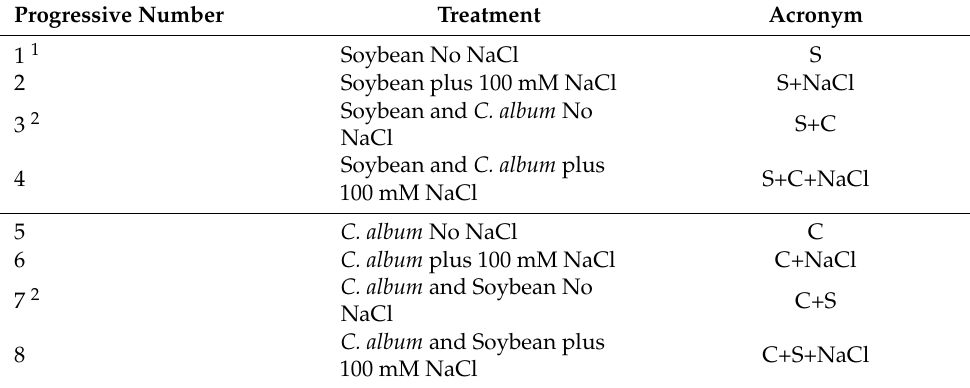
Table 1. Treatment applied and corresponding acronyms in the